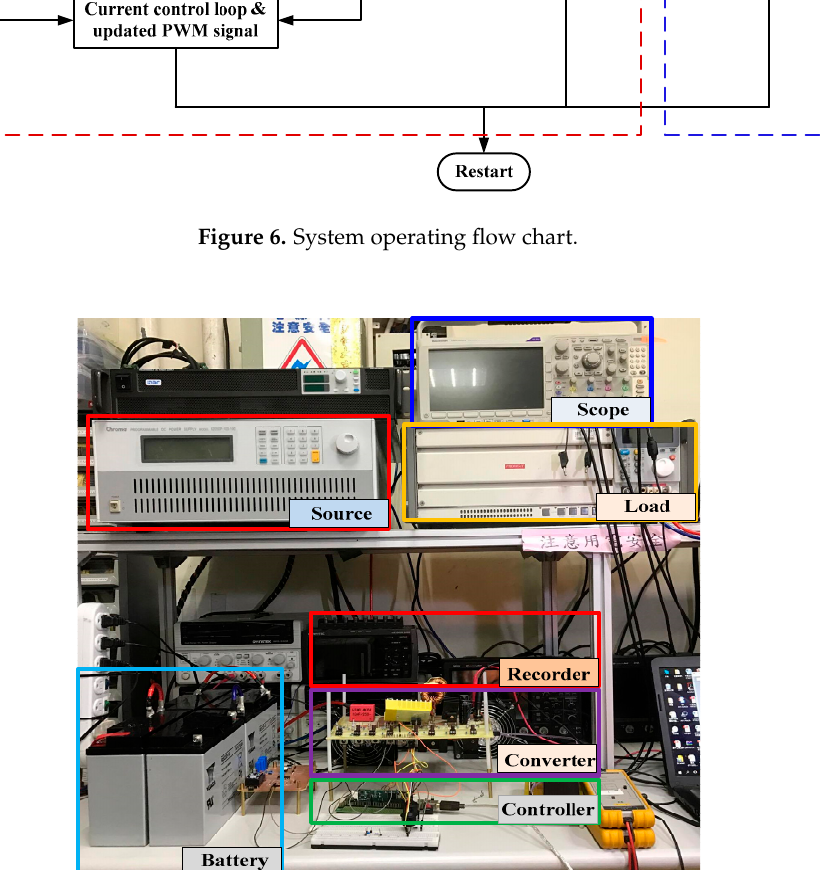
Figure 7. Test platform for the proposed high-gain RC-BDC.